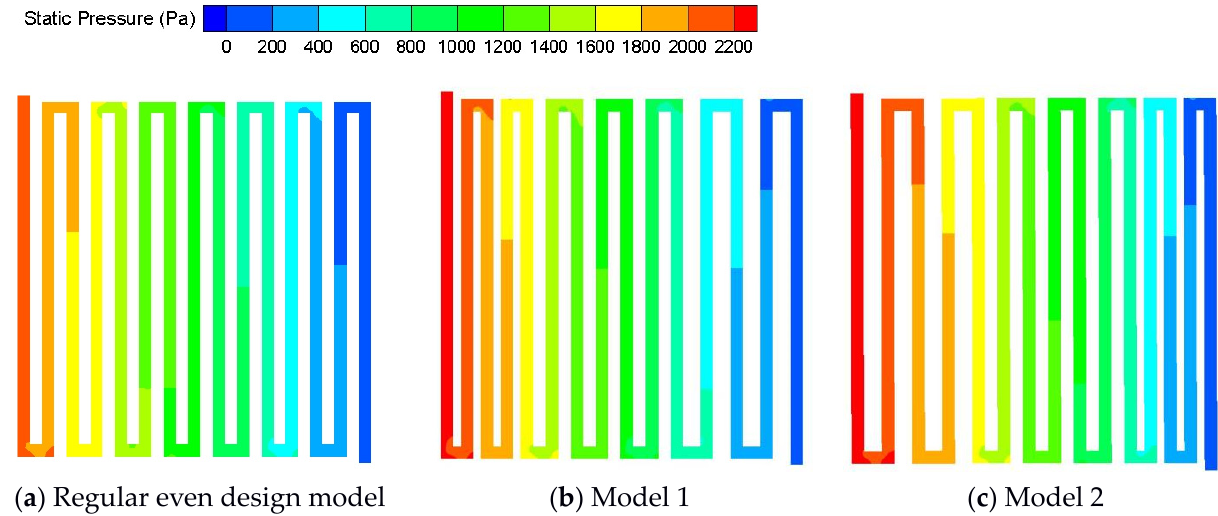
Figure 3. Pressure distribution in the cathode flow channel.